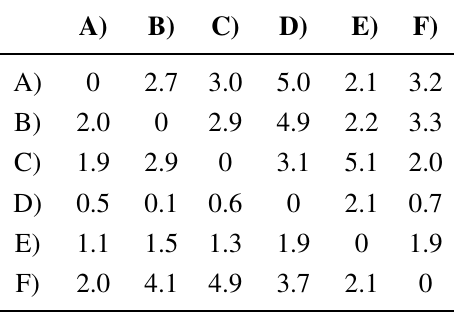
Table 1. Fictitious example for network integration and network